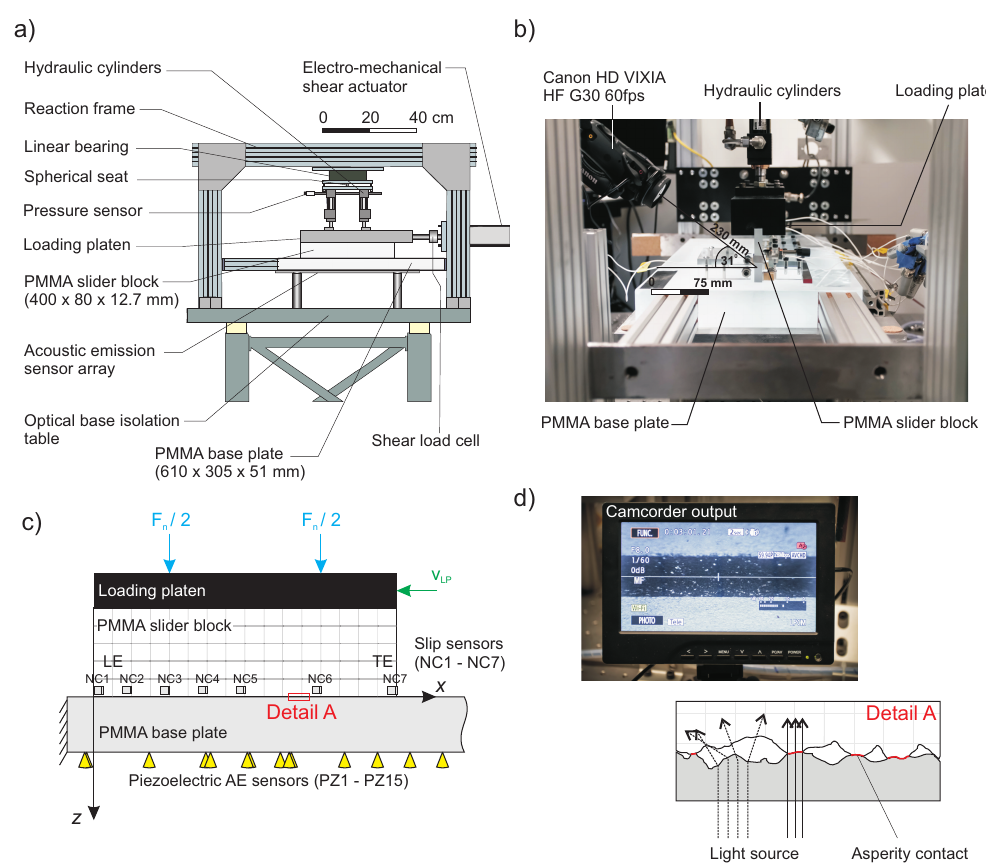
Figure 1. ( a ) An overall schematic representation of the direct shear friction apparatus and its major components; ( b ) a photograph of the apparatus showing the location of the video camera in relation to the frictional multicontact interface (MCI); ( c ) general configuration of the direct shear apparatus from the side view with general locations for the non-contact eddy current (NC1–NC7) and acoustic emission (AE) piezoelectric sensors (PZ1–PZ15). These sensors were used to detect dynamic changes as the fault began to fail; ( d ) (top) A photograph of the monitor used to display the video camera images in real time. Asperities appear as the bright spots within the darker, interface region. (bottom) A schematic representation of Detail A from ( c ) depicting the theory, which describes the transmission of light through asperities (solid lines) and diffracted light along the void space (dashed